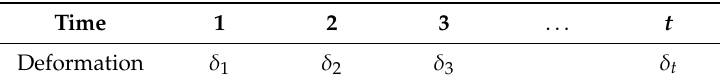
Figure 2. Cross-section data diagram.